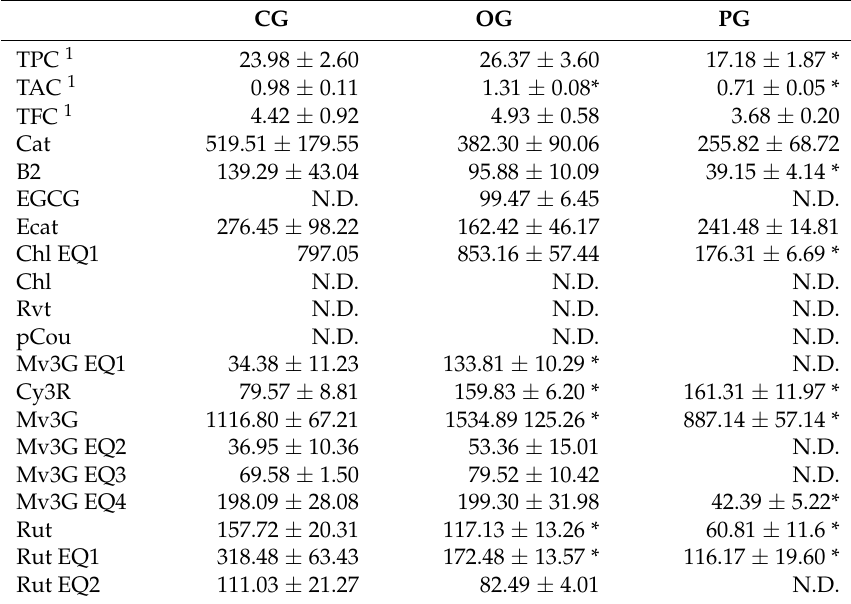
Table 4. Generic polyphenol variables and individual polyphenol contents analyzed by HPLC-DAD of conventional whole Grenache grapes (CG), red organic whole red Grenache grapes (OG), and whole red Peruvian Red Globe grapes